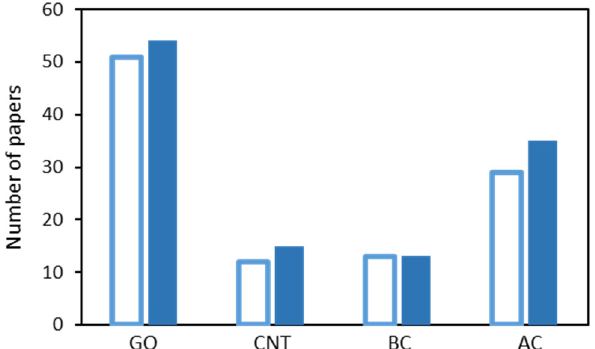
Figure 4. Number of papers published in 2019 (open) and 2020 (solid) focussed on various CS/carbon-based materials, where the carbon materials are graphene oxide (GO), carbon nanotubes (CNT), biochar (BC) and activated carbon (AC). All data taken from Scopus.